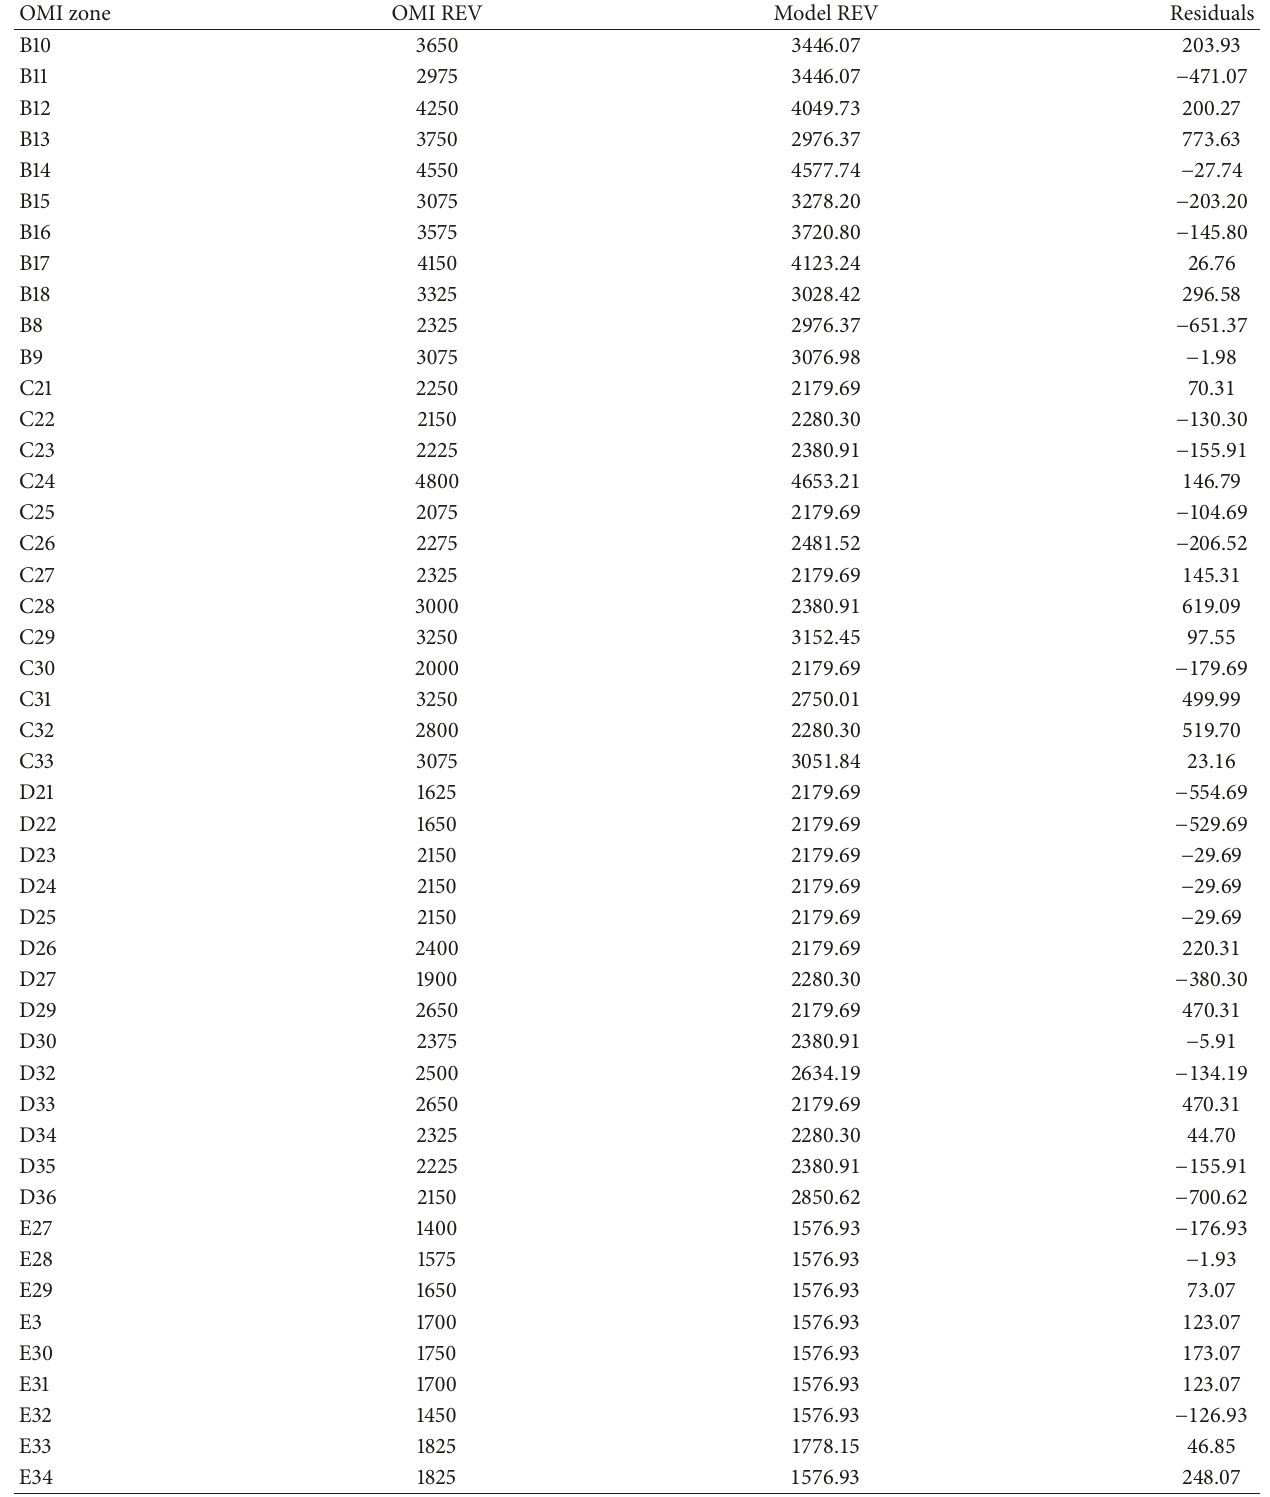
Table 8: Residuals for model